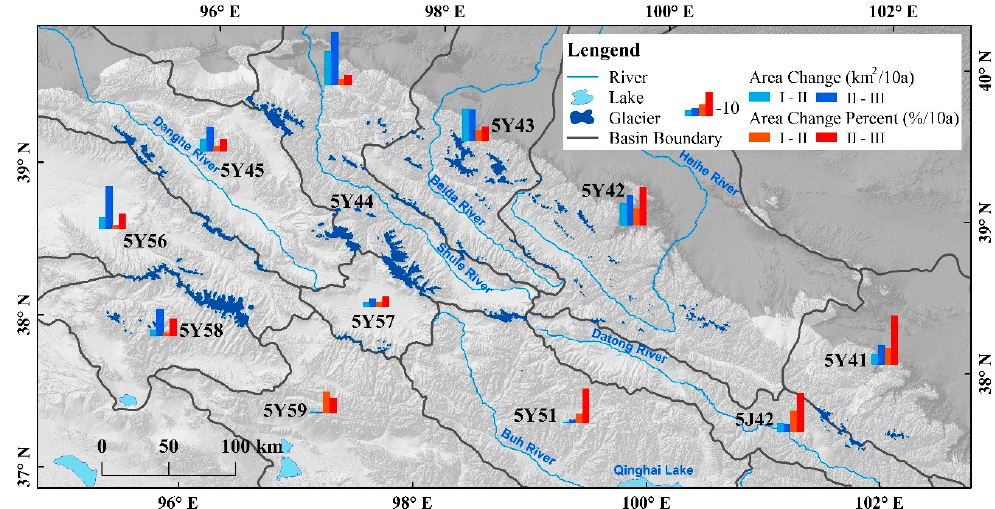
Figure 9. Area changes of glaciers at drainage scale in the Qilian Mountains from three inventories.